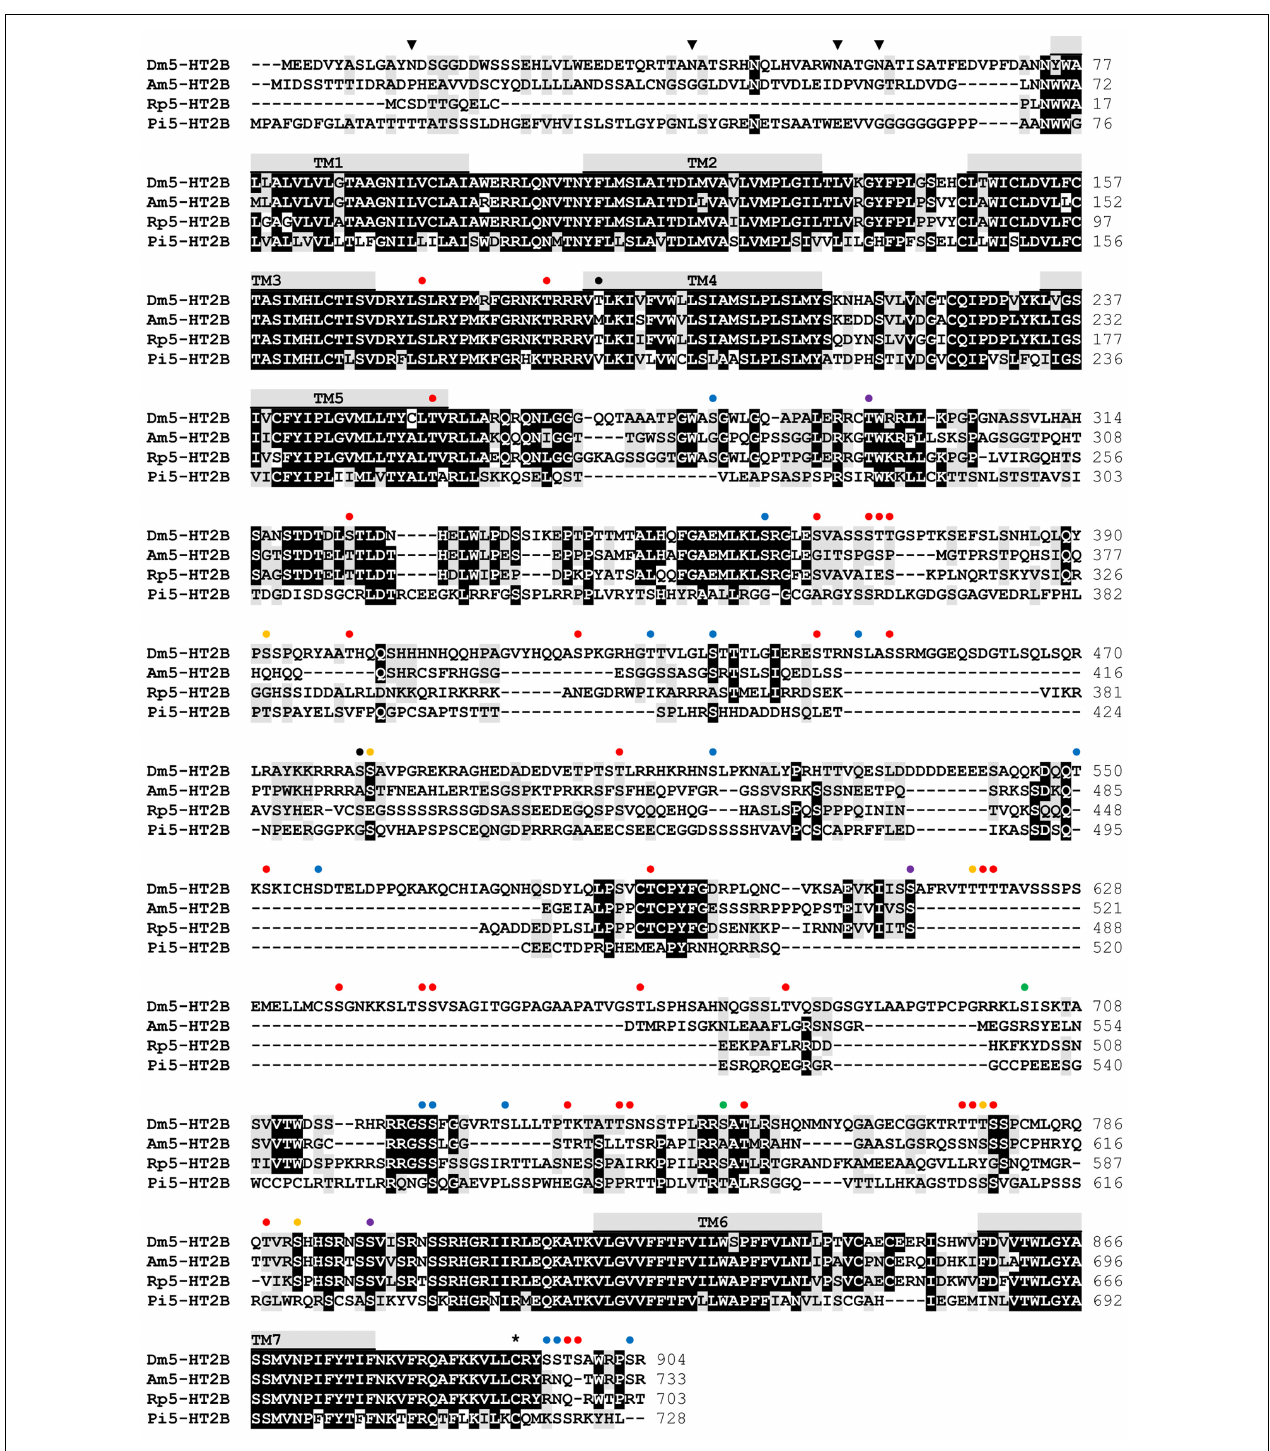
FIGURE 2 | Amino acid sequence alignment of Dm5-HT 2B and orthologous receptors from Apis mellifera (Am5-HT 2B , CBX90121), Rhodnius prolixus (Rp5-HT 2B , AKQ13312), and Panulirus interruptus (Pi5-HT 2B , AAS57919). Identical residues ( ≥ 75%) are shown as white letters against black, whereas conservatively substituted residues are shaded. Putative transmembrane domains (TM1–TM7) are indicated by gray bars. Potential N-glycosylation sites ( (cid:72) ), PKA phosphorylation sites ( • ), PKC phosphorylation sites ( • ), phosphorylation sites for both PKA and PKC ( • ), PKG phosphorylation sites ( • ), phosphorylation sites for both PKA and PKG ( • ), phosphorylation sites for all three kinases ( • ), and putative palmitoylation sites ( ∗ ) of Dm5-HT 2B are indicated. The amino acid position is given on the